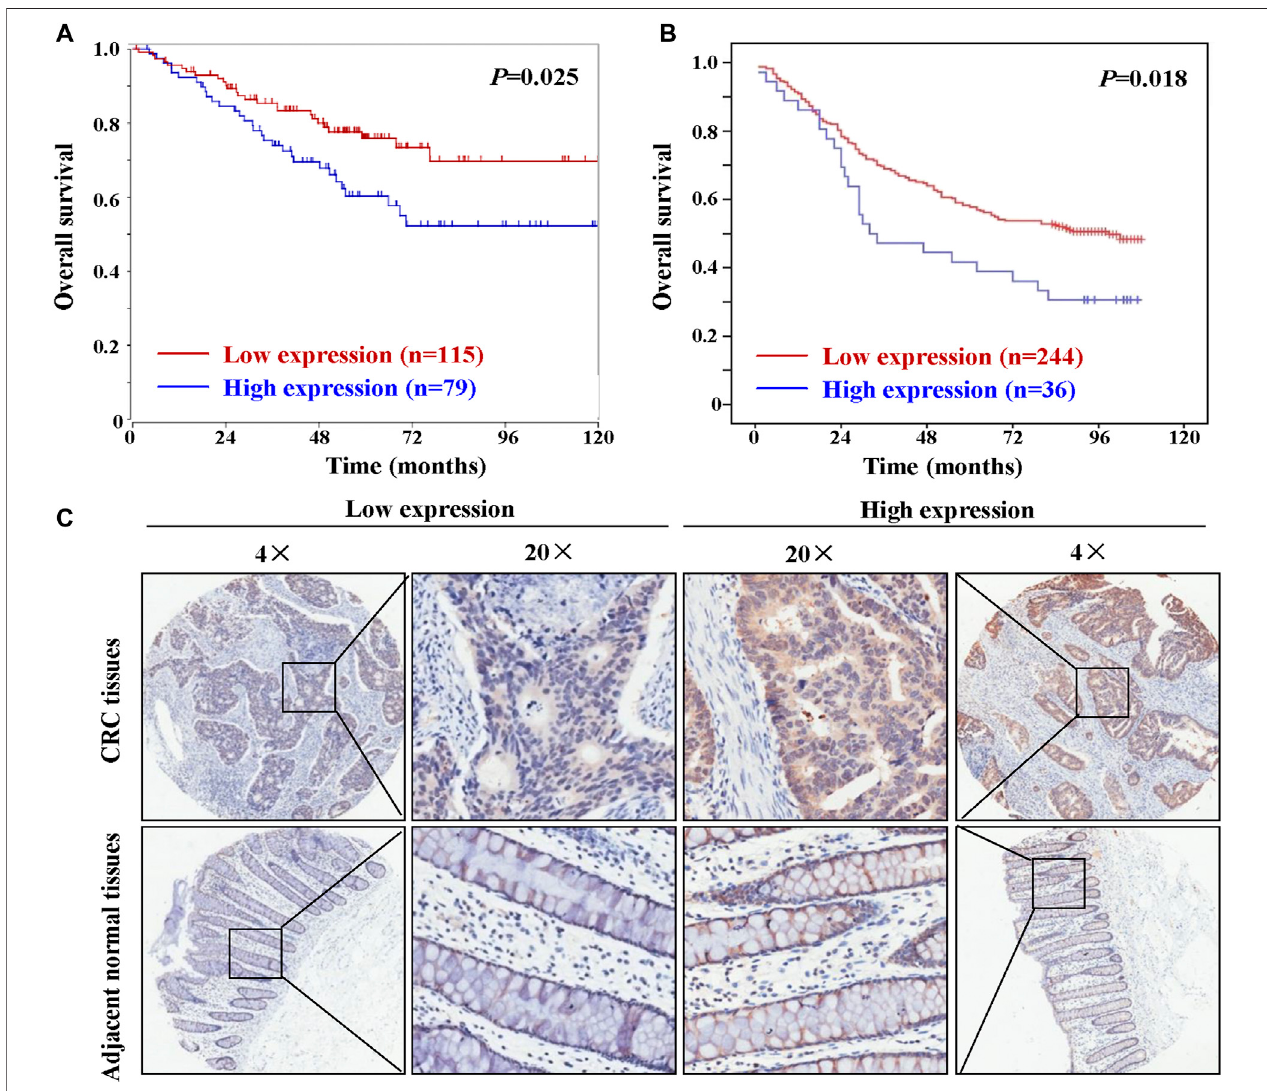
the log-rank test. (B) Kaplan-Meier plots showing overall survival of 280 CRC patients with low and high HAUS6 protein expression by Kaplan-Meier using the log-rank test. (C) Representative immunohistochemistry images showing high or low HAUS6 expression. Magni fi cation: × 4 and ×